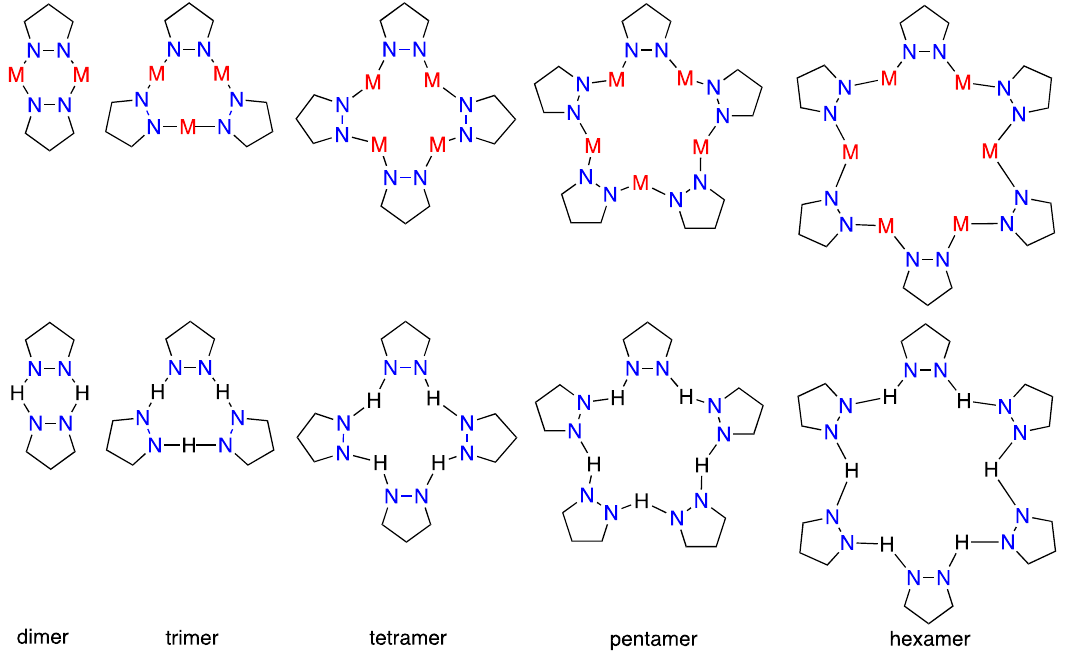
Figure 1. Metallacycles ( top ) and the corresponding cyclamers ( bottom ).